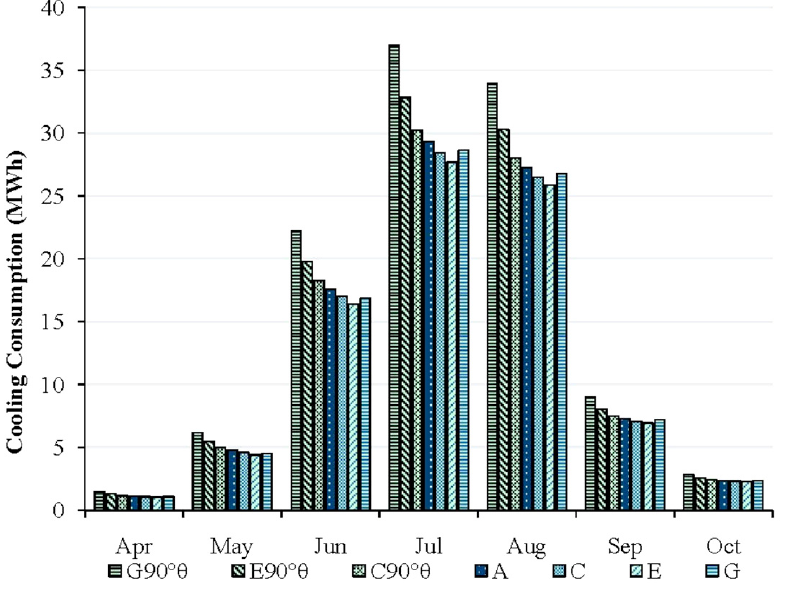
Figure 10. Monthly cooling consumption for different aspect ratios in